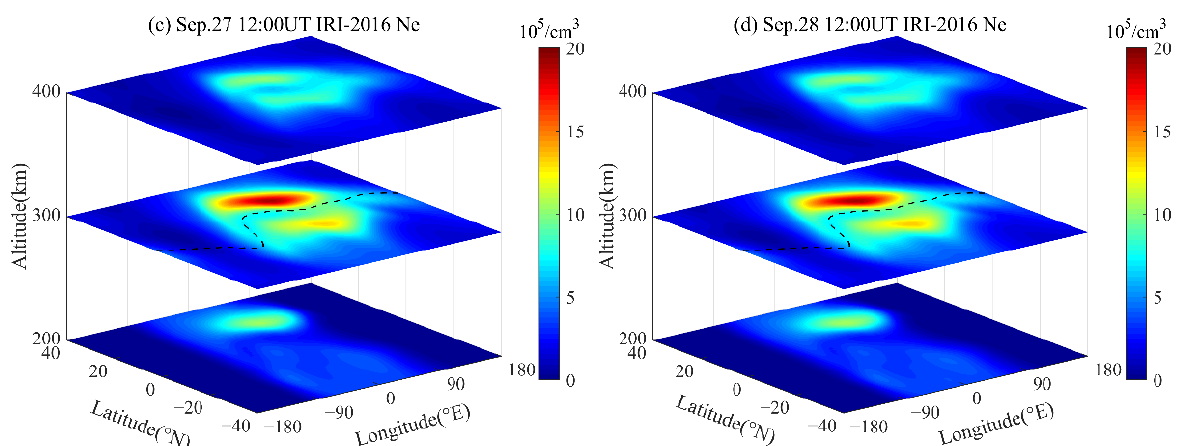
Figure 12. Snapshots of the distribution of electron density obtained from COSMIC-2 RO profiles ( top row ) and IRI-2016 model ( bottom row ) at 200, 300, and 400 km altitudes at 12:00UT on September 27 ( left column ) and September 28 ( right column ). The black dashed lines in slices of 300 km height are the magnetic equator lines.